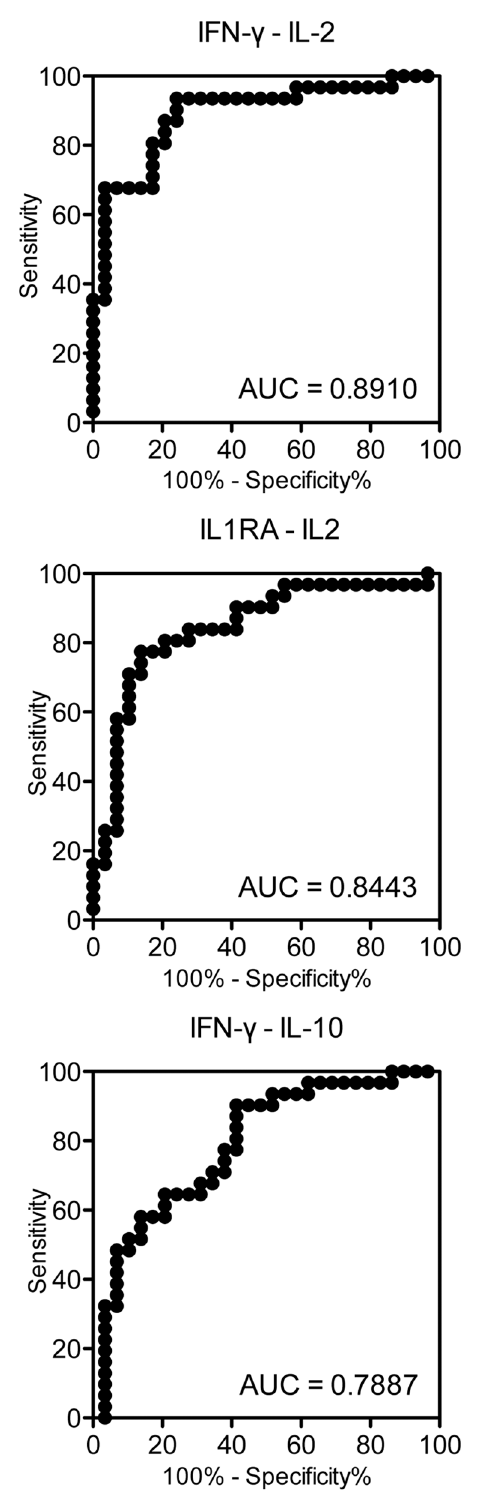
Fig 4. ROC curves comparing the diagnostic accuracy of differences between two cytokines in TBAg – Nil supernatants for differentiating active TB from LTBI. The AUCs are shown.